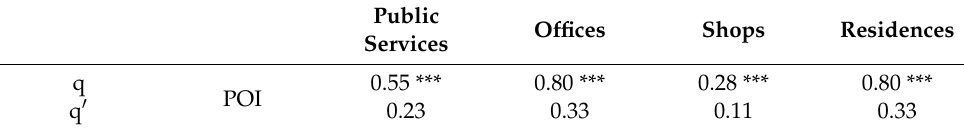
Public Offices Shops Residences Services